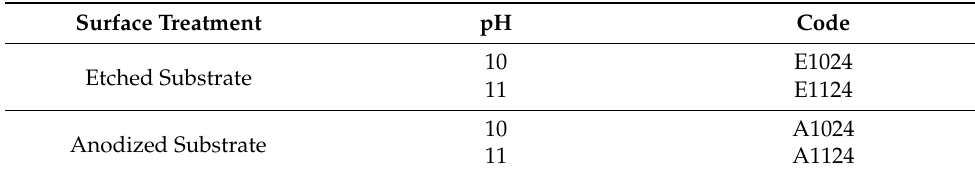
Table 1. Codes used for LDH